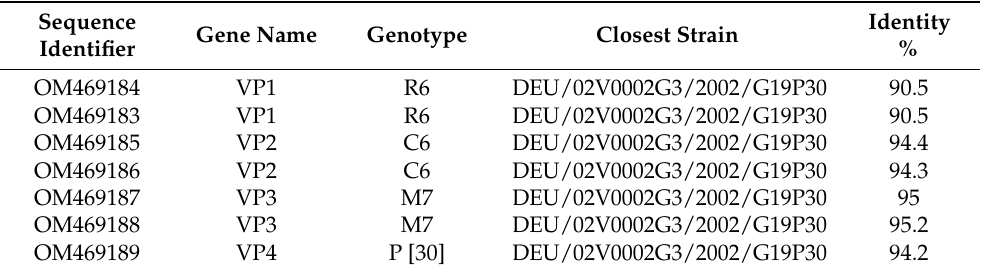
Table 3. Results from genotyping RVA segments from this study using the annotation pipeline available at